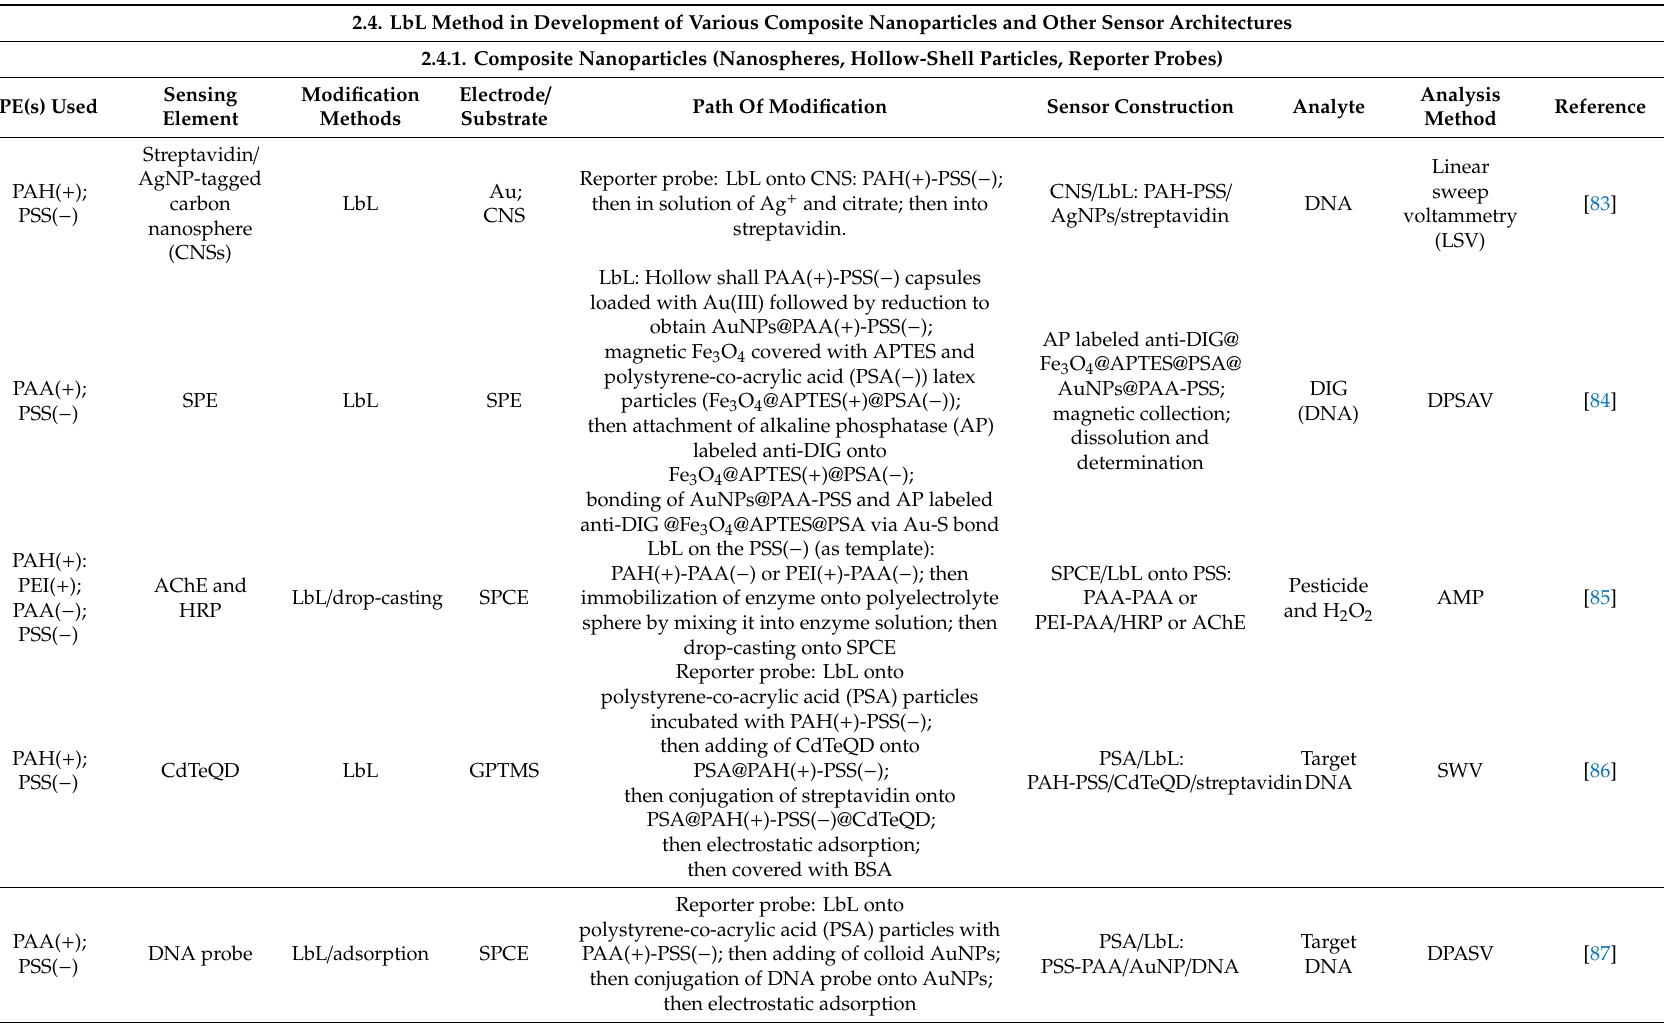
Table 4. Summary of electrochemical sensors based on the application of the LbL method in the development of various composites. 2.4. LbL Method in Development of Various Composite Nanoparticles and Other Sensor